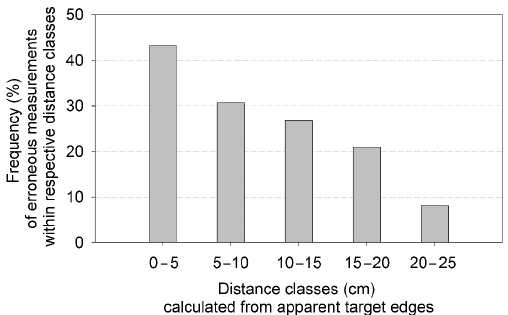
Figure 6. Frequency of erroneous USH measurements (% of all measurements within a distance class) at different distance from ap- parent target edges (considering target dimensions and sensor prop-